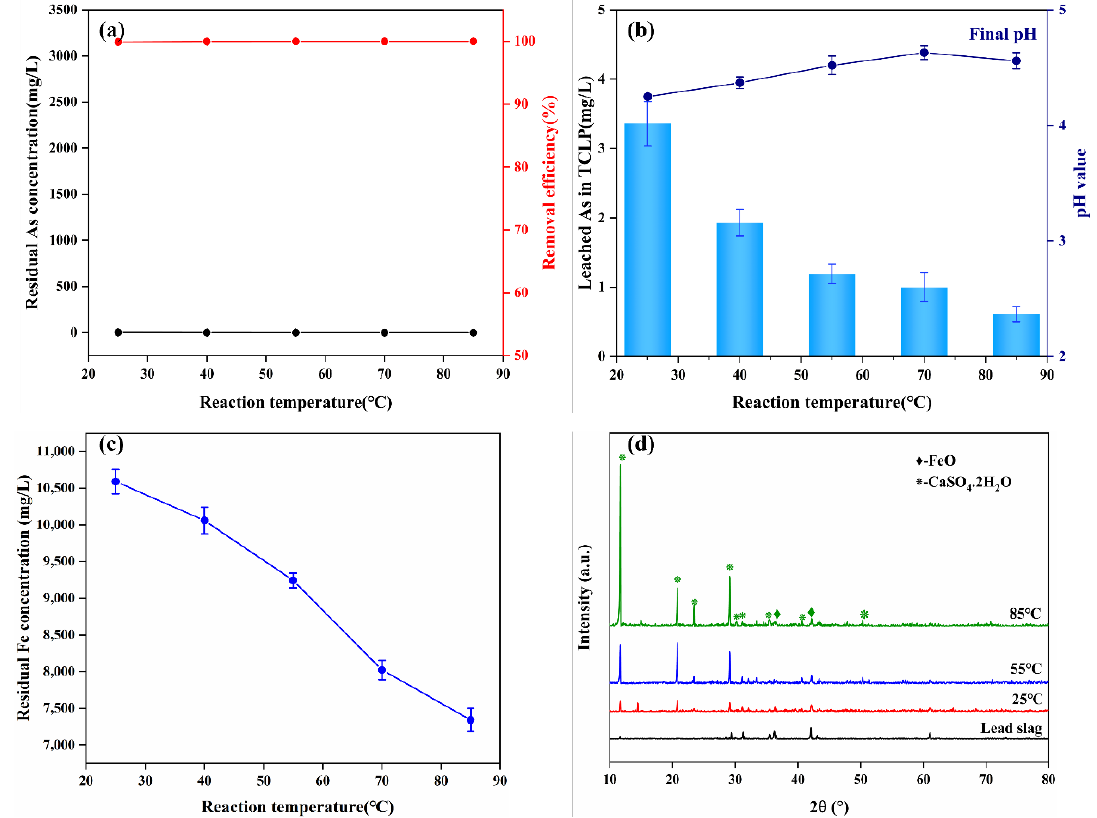
Figure 7. Variations of residual concentration and removal efficiency of As ( a ), leached arsenic concentration in TCLP and final pH value of wastewater ( b ), residual concentration of Fe in bath experiments at reaction temperature of 25, 40, 55, 70, and 85 ◦ C ( c ), XRD pattern of the arsenic-loaded precipitates obtained from bath experiments at reaction temperature of 25, 55, and 85 ◦ C (solid–liquid ratio of 1:10 and H 2 O 2 volume ratio of 10%) and lead slag ( d